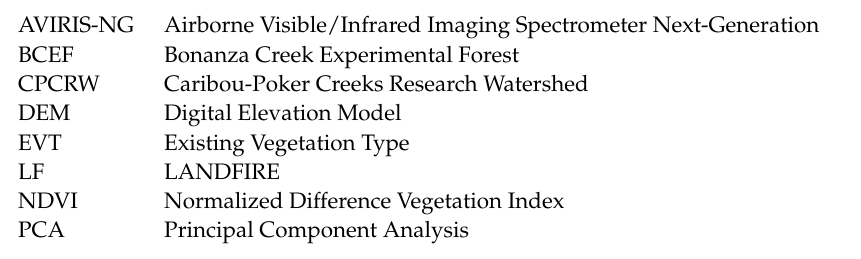
forest 304 band AVIRIS BCEF product. Table S7: Vegetation type error matrix table on the random forest 304 band AVIRIS CPCWR product. Table S8: Vegetation type error matrix table on the random forest 5 band PCA AVIRIS CPCRW